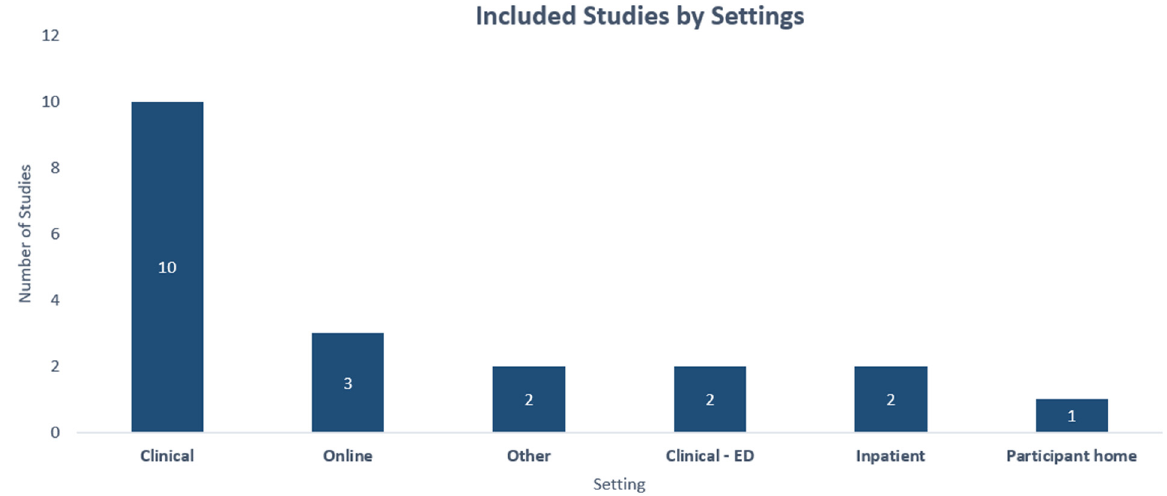
Figure 2. Studies by settings.